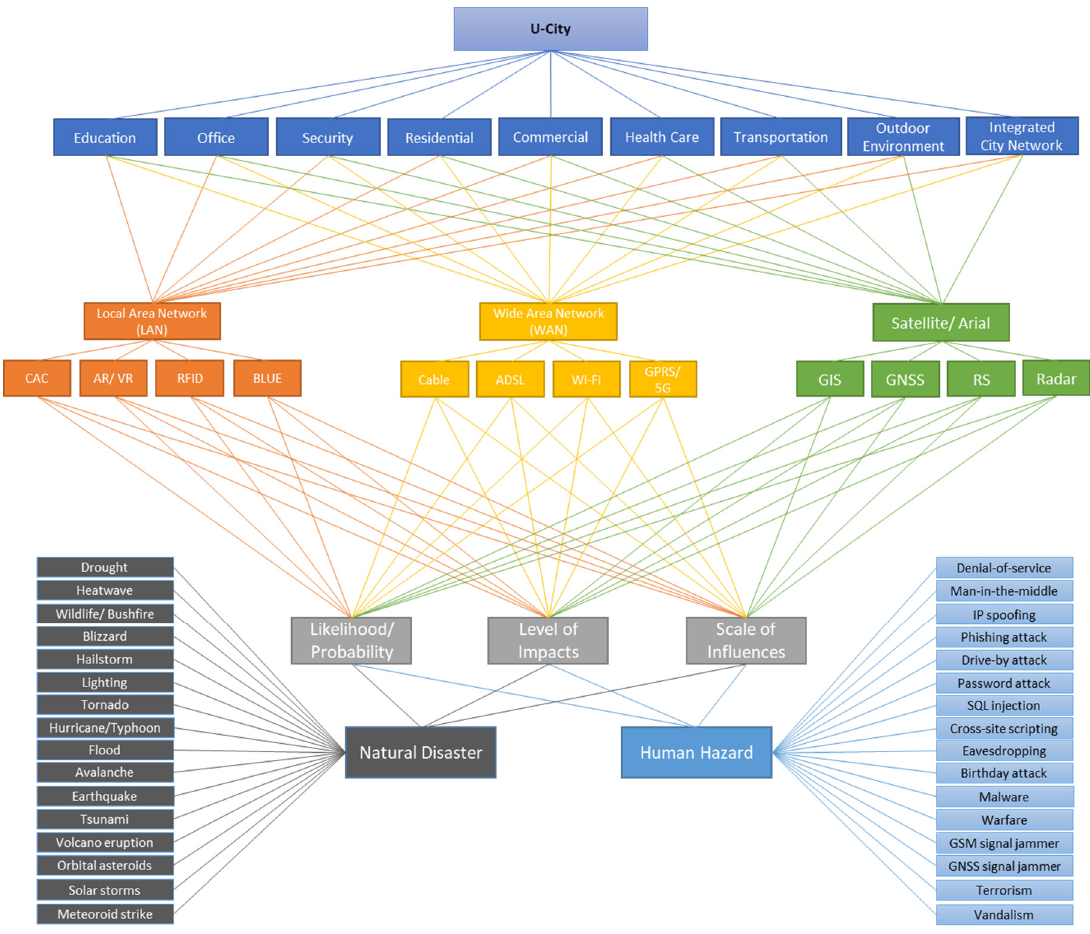
Figure 6. A vulnerability assessment of U-city under natural and man-made hazards for ICTs and areas using AHP.